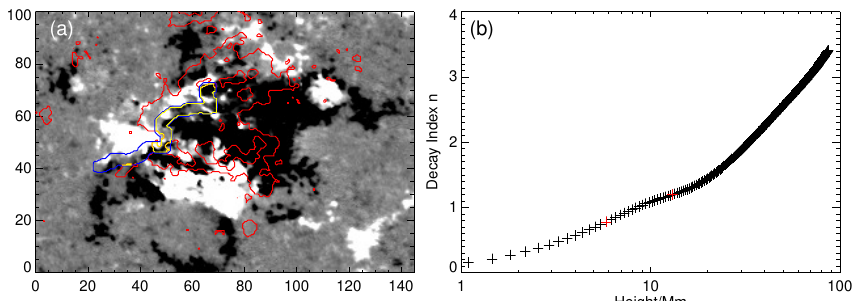
Figure 11. ( a ) Magnetic flied of active region NOAA 10387 on Dec 25, 08:36 UT, with red contour for the flare region at the peak time, blue contour for PIL and yellow contour for the intersection of the first two; ( b ) the height profile of the decay index above the FPIL region as outlined by yellow contour in Panel